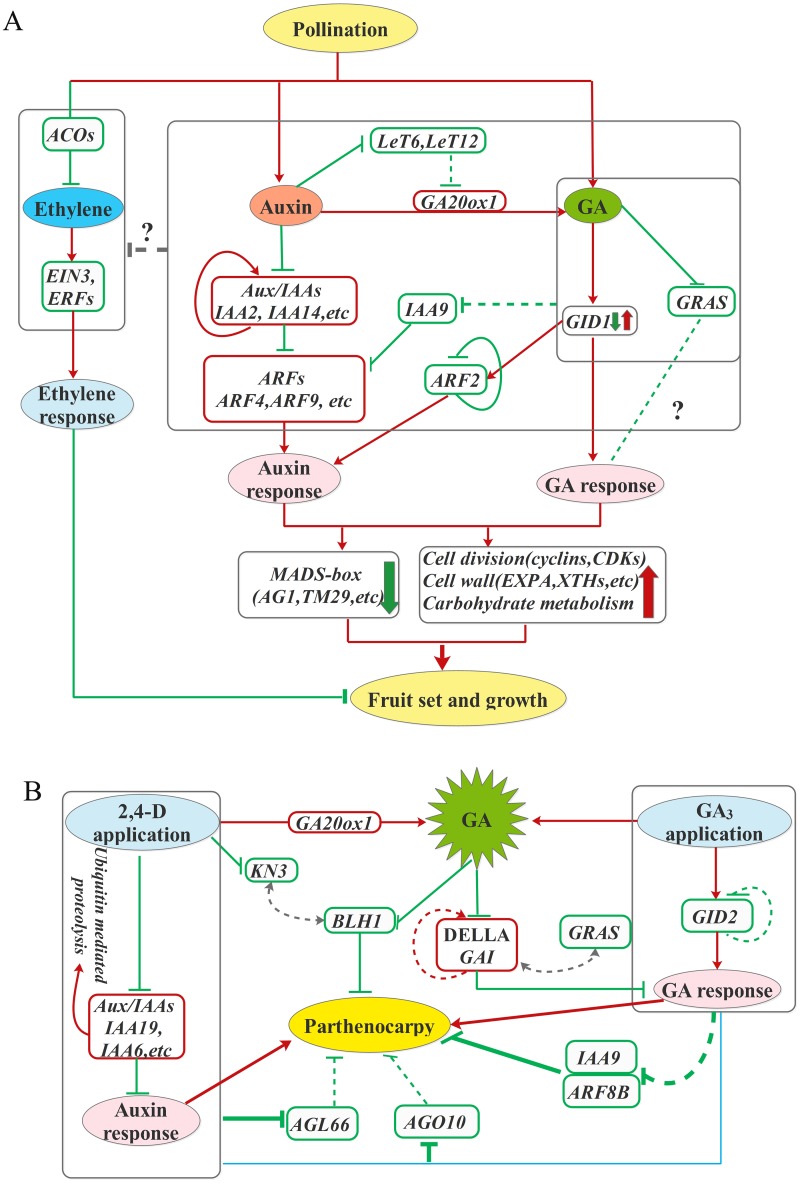
Model for regulatory events underlying fruit set mainly mediated by auxin and gibberellin.(A) After pollination, the increase of auxin and GA biosynthesis and response will trigger fruit initiation. And the elevated auxin and GA would inhibit ethylene biosynthesis and response which negatively regulate fruit set. Auxin stimulates GA biosynthesis gene GA20ox1 via down-regulating KNOX (LeT6, LeT12) in partially, subsequently influences GA response by regulating GID1 and GRAS. Some Aux/IAAs may be degraded by the 26S proteasome and in turn, the transcripts are increased via feedback regulation to fine-tune auxin response. Some ARFs (ARF4, ARF9) are up-regulated which could promote auxin signaling cascades. In addition, auxin response may be mediated by GA via down-regulation of IAA9 and ARF2 during fruit set. Accordingly, events that the activation of carbohydrate metabolism, cell division and expansion as well as the down-regulation of MADS-box occur to promote fruit set process. (B) After 2, 4-D application, KNAT3 displayed down-regulation, which would interact with BLH1, thus negatively regulating parthenocarpy. In the present of GA, the transcripts of DELLA and GID2 are regulated via feedback to fine-tune GA response. GA application decreased the transcripts of IAA9 and ARF8B, and then led to parthenocarpy. Moreover, other factors such as GRAS, AGL66 and AGO10, which are down-regulated after hormone application, also seem to have a regulatory role in parthenocarpy. The red and green frame shows up- and down-regulation, respectively. The red line arrow and the green line behind represent positive and negative regulation, respectively. The regular arc line represents feedback regulation. Dashed line shows suggested interactions.